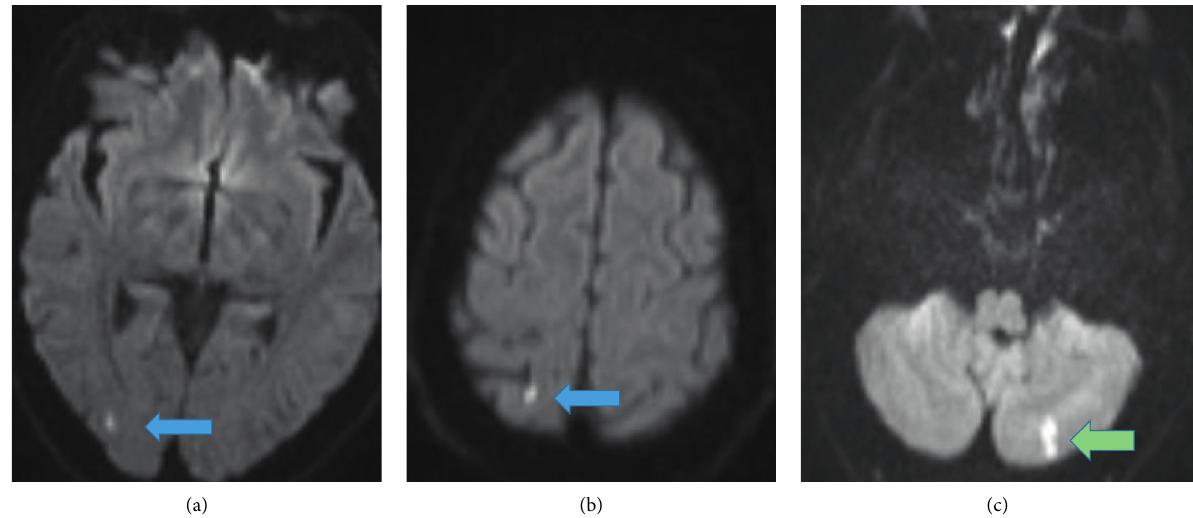
Figure 1: MRI of brain without contrast. Blue arrows: occipital and parietal tiny infarcts. Green arrow: cerebellar infarct.